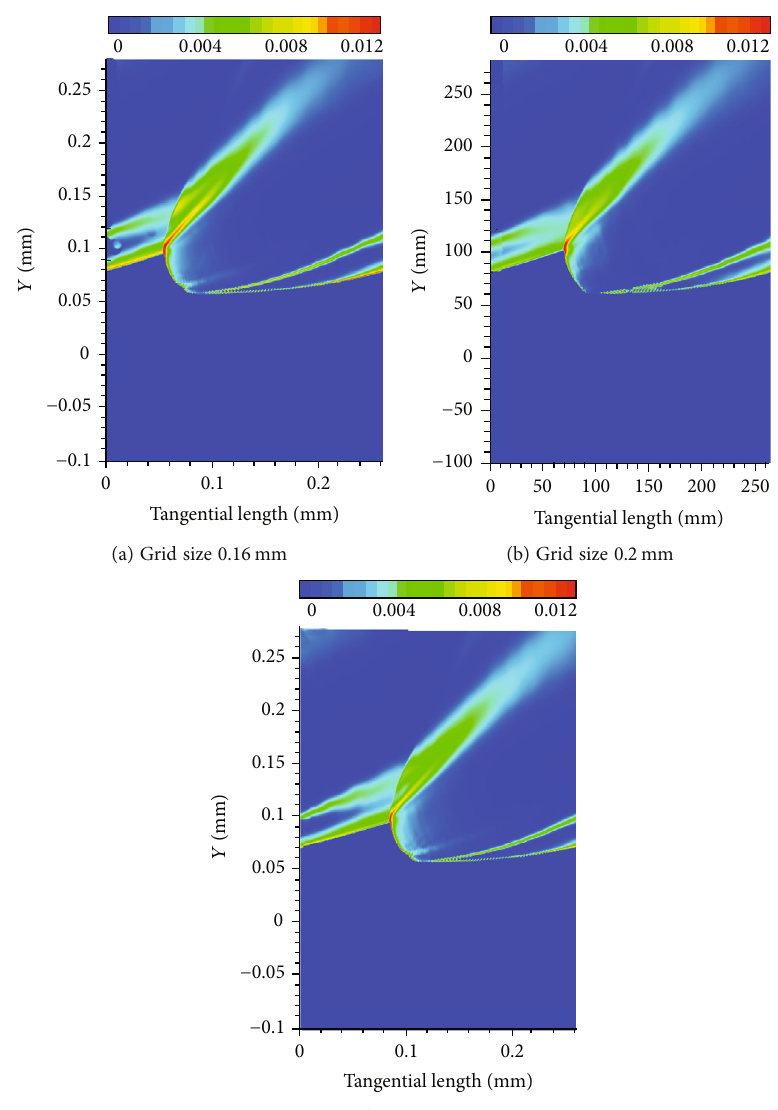
Figure 2: OH contours of three di ff erent grid sizes: (a) 0.16mm; (b) 0.2 mm; (c) 0.25 mm. Table 1: Main parameters of the detonation wave of the two cases. Detonation wave